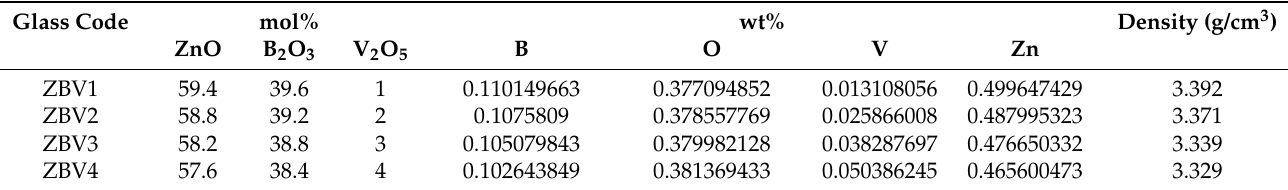
Figure 1. Studied glass samples [35] and their physical/optical appearances. Table 1. Chemical compositions and density for glass samples.